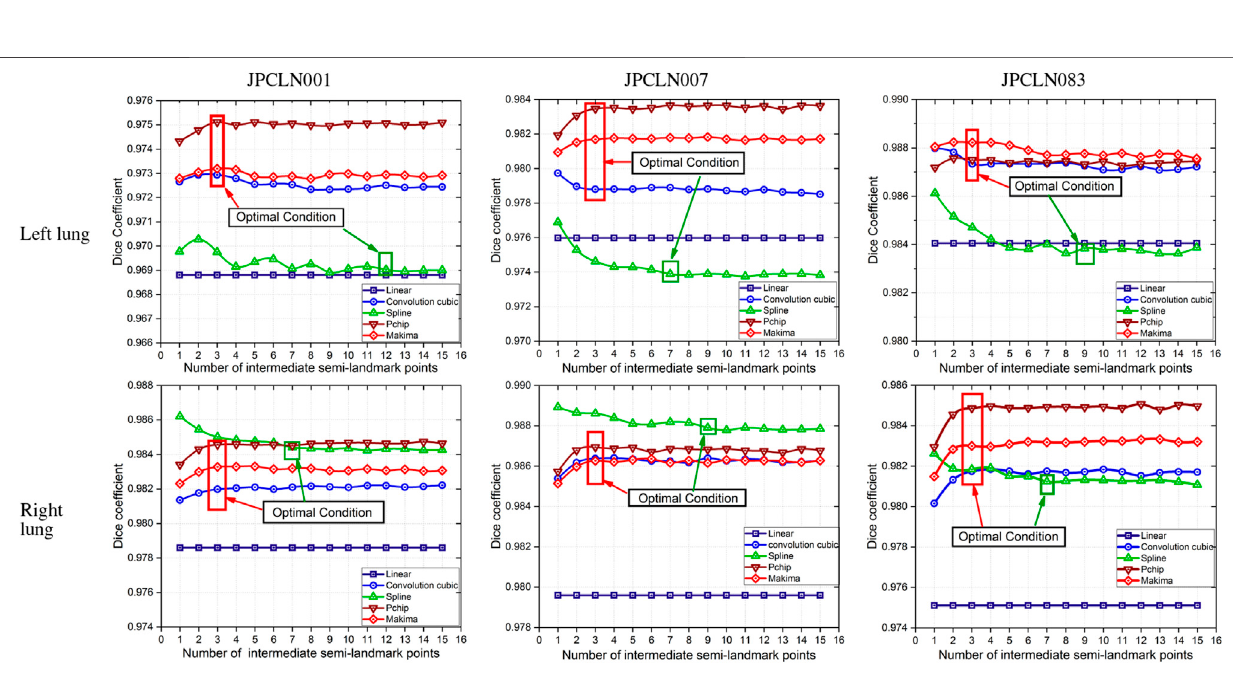
Frontiers in Physics |